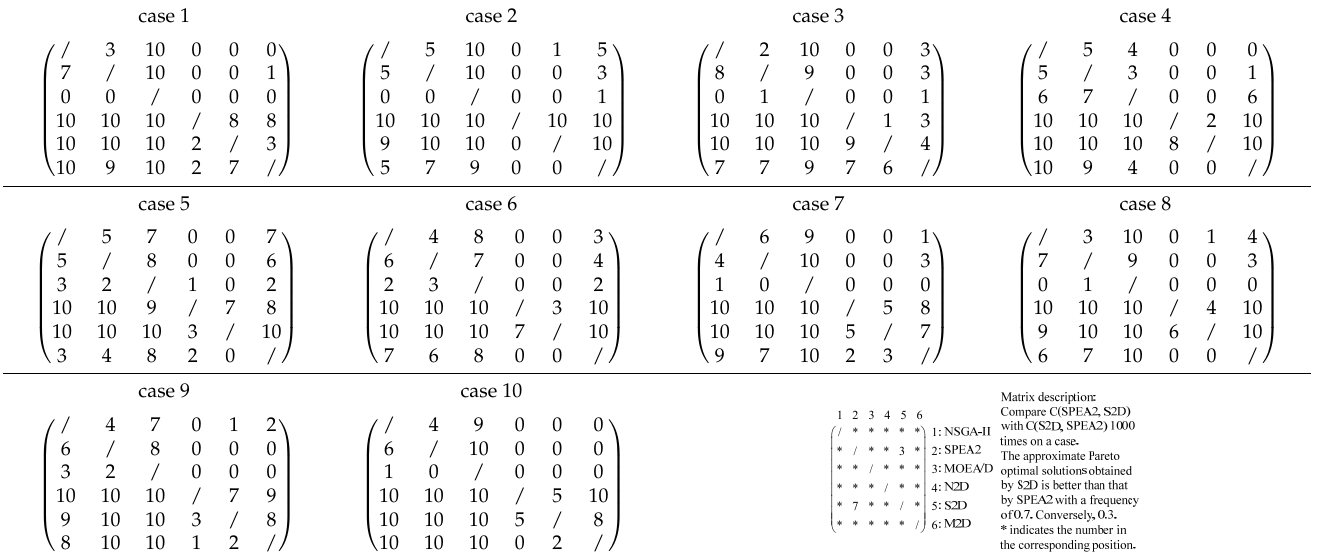
Table 4. The calculation results of C .